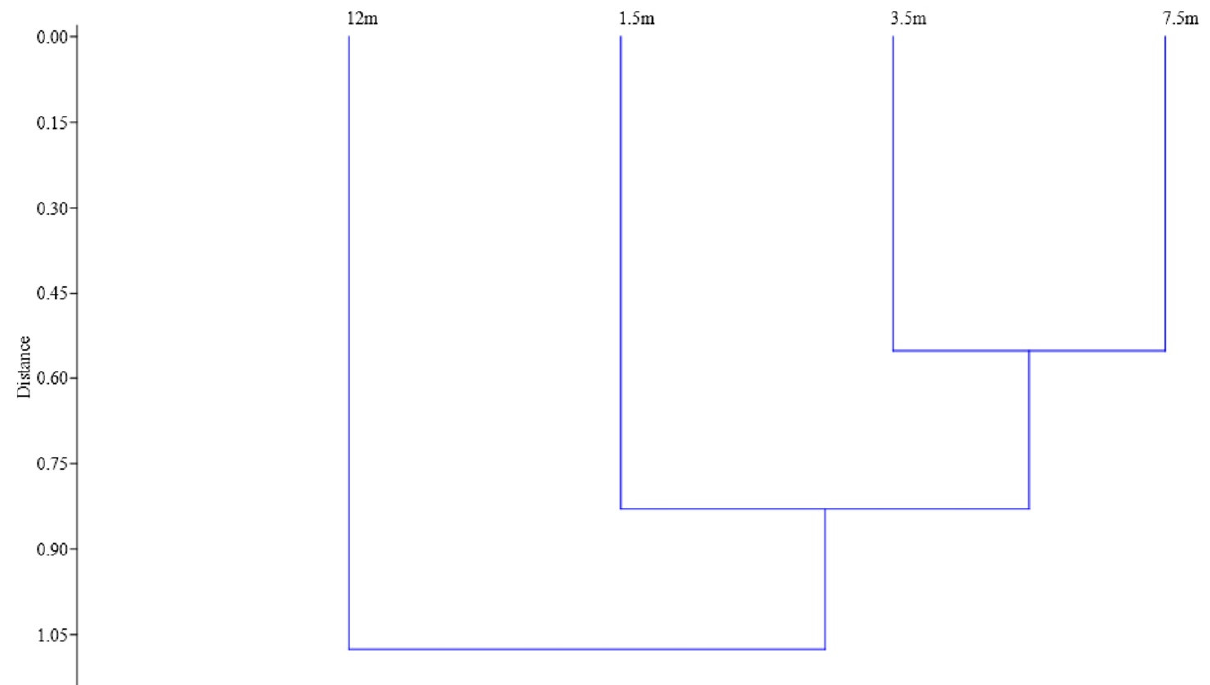
Figure 5. The insect species composition similarity for four studied heights based on Jaccard similarity index, by using Ward’s method and Euclidean distances as measurement of Linkage Distance (cophenetic correlation coefficient = 0.670).